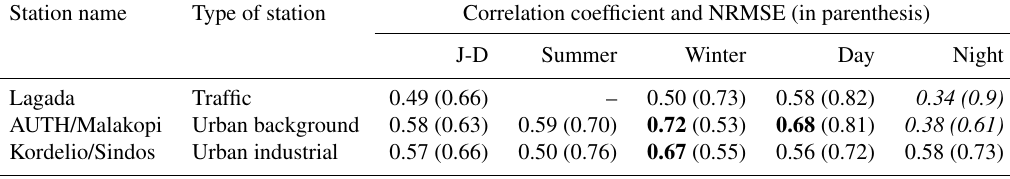
Table 1. Correlations and normalized root mean square error (NRMSE) values (in parenthesis) between the NO 2 surface observations at the in situ stations in Thessaloniki and the surface concentrations calculated at the corresponding model grid cell. Correlations higher than 0.6 are marked in bold, while the correlations lower than 0.4 are marked in italic. All correlation coefficients are statistically significant at the 95% level.